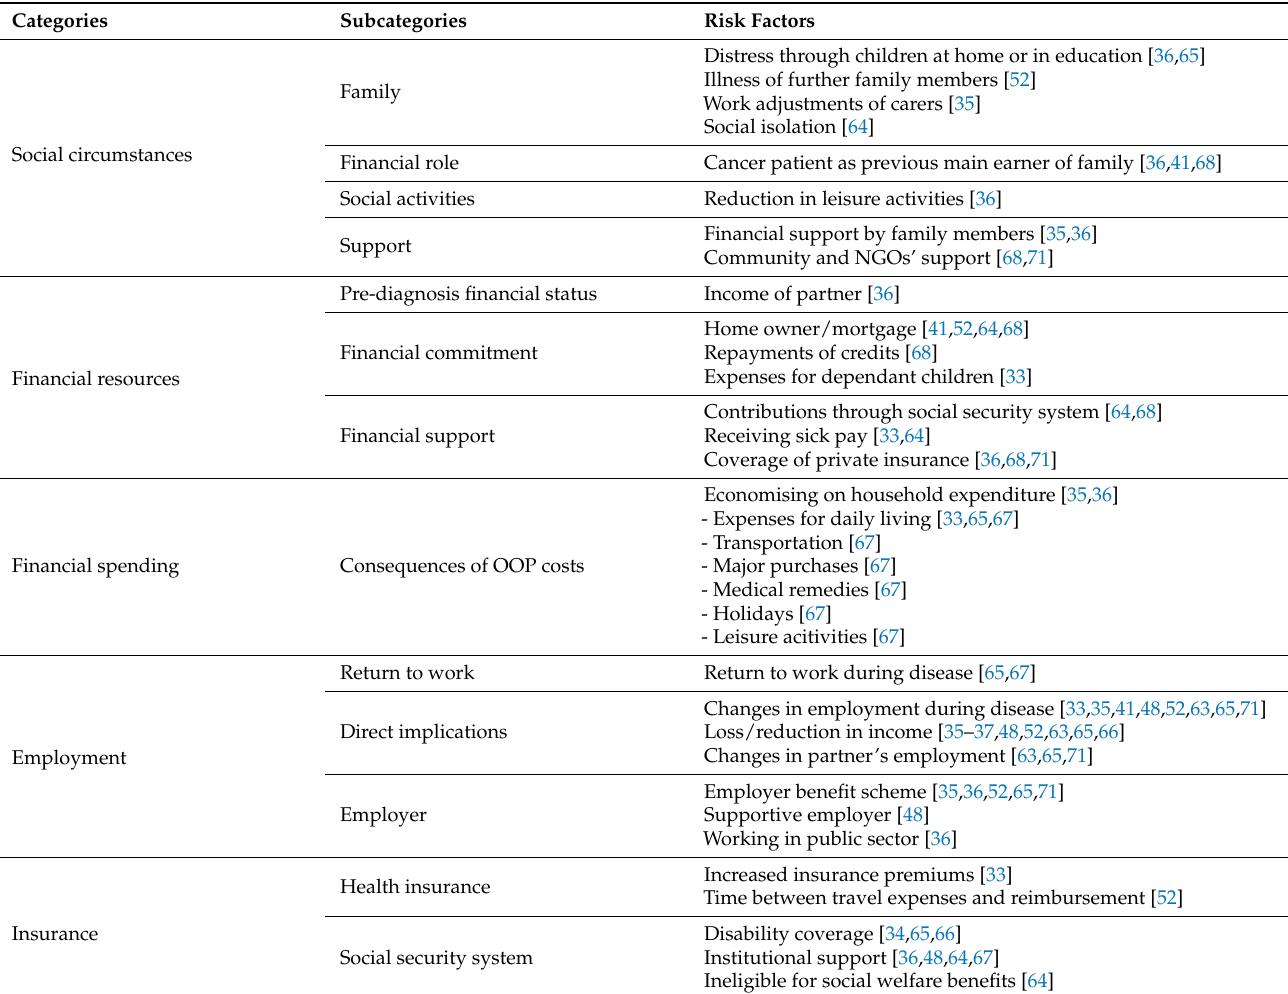
Table 4. Not Evaluated Risk Factors in Quantitative